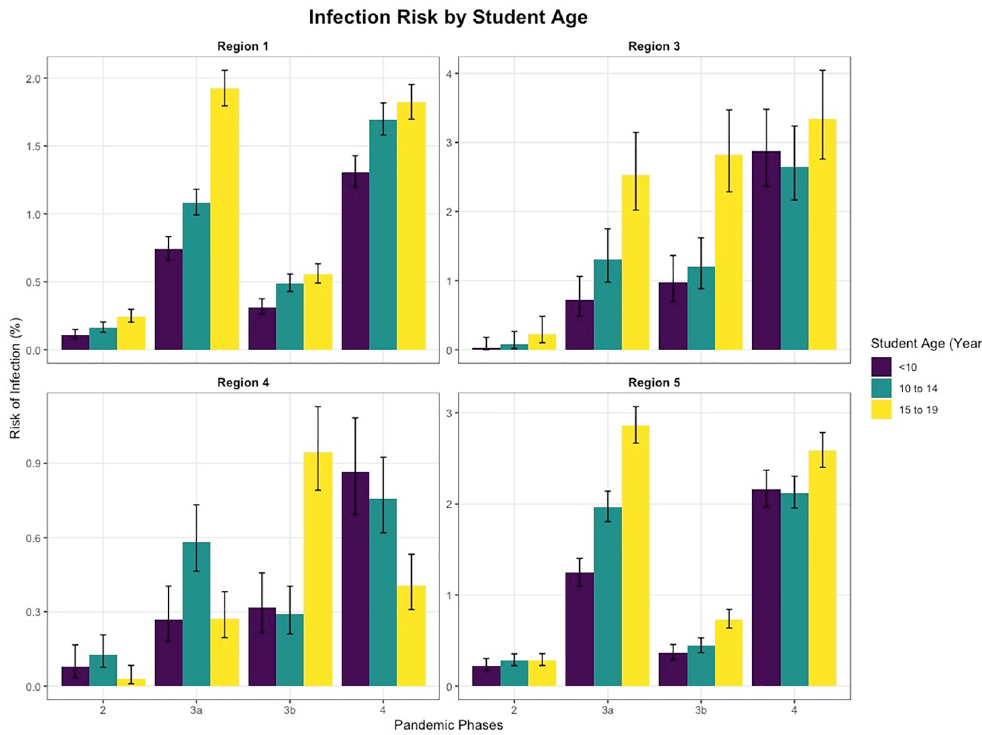
Fig 3. Cumulative risk of infection of students by age over time in 4 regions. Error bars show CI for risk of infection. Based on detailed data by 5 regional agencies. Phase 2 summer plateau 2020, phase 3a second wave with open schools, phase 3b second wave with school closures, phase 4 mixed class models and VOC alpha. CI, confidence interval; VOC, variant of